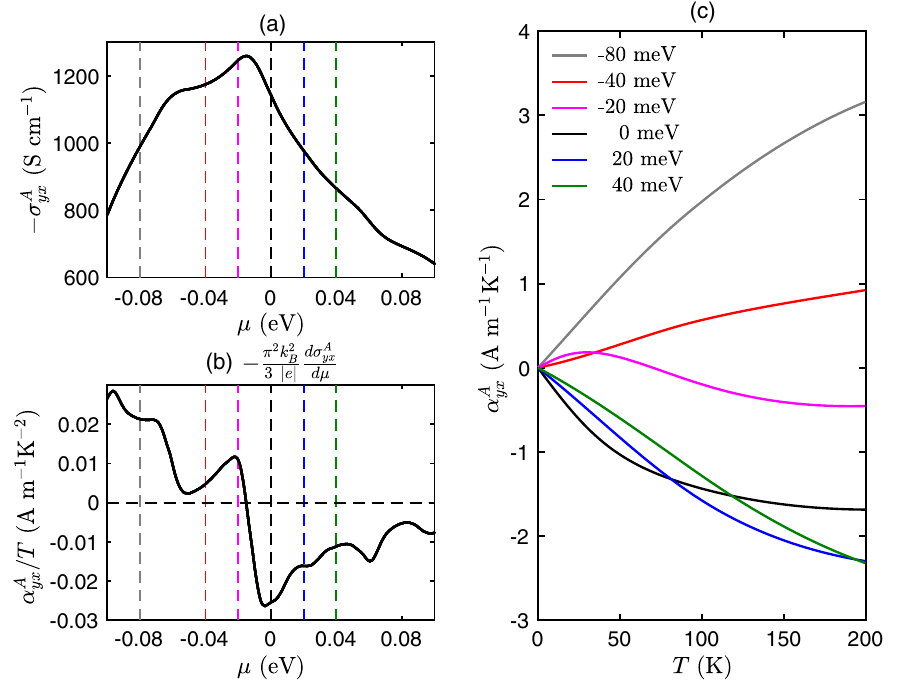
FIG. 7. Theoretical σ A yx and α A yx . (a) Anomalous Hall conductivity at 0 K as varying the chemical potential μ . The charge neutral point is set to zero. (b) The slope of α A yx to T in the Mott relation [Eq. (12)]. (c) Temperature dependence of α A yx at different chemical